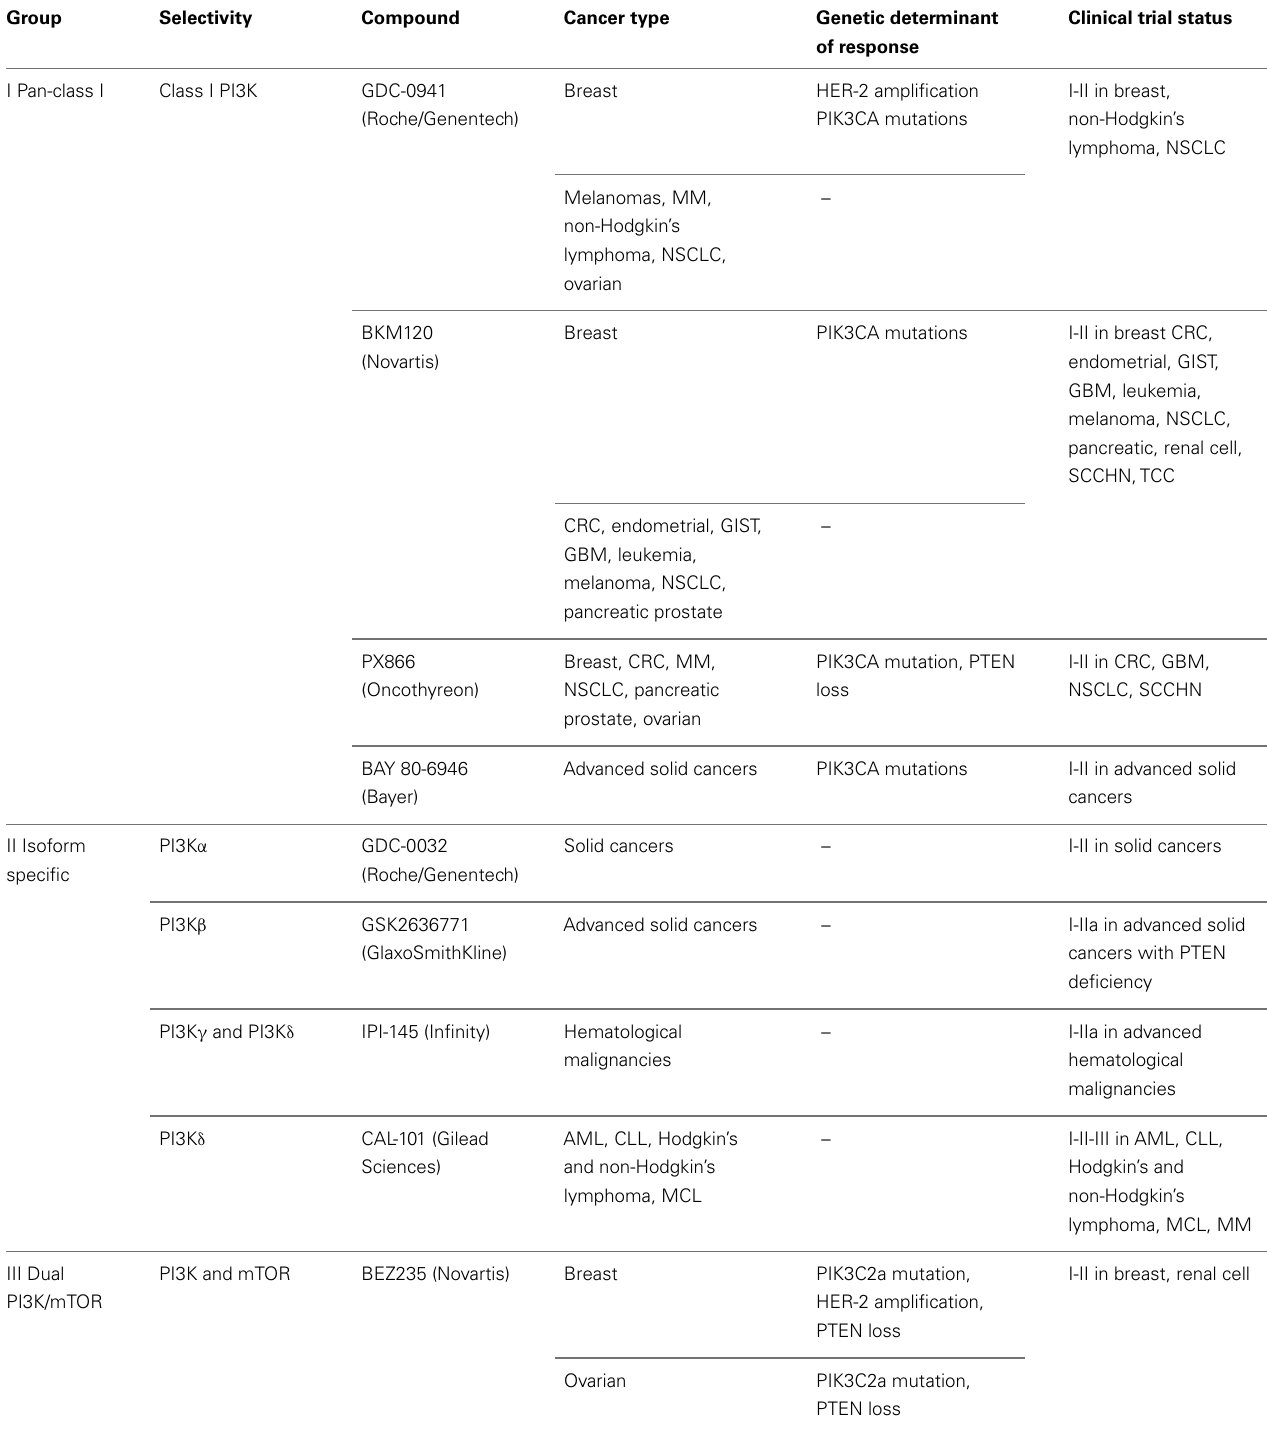
Table 1 | PI3K inhibitors tested in preclinical and clinical models, genetic determinants of response, and open clinical trials described for each